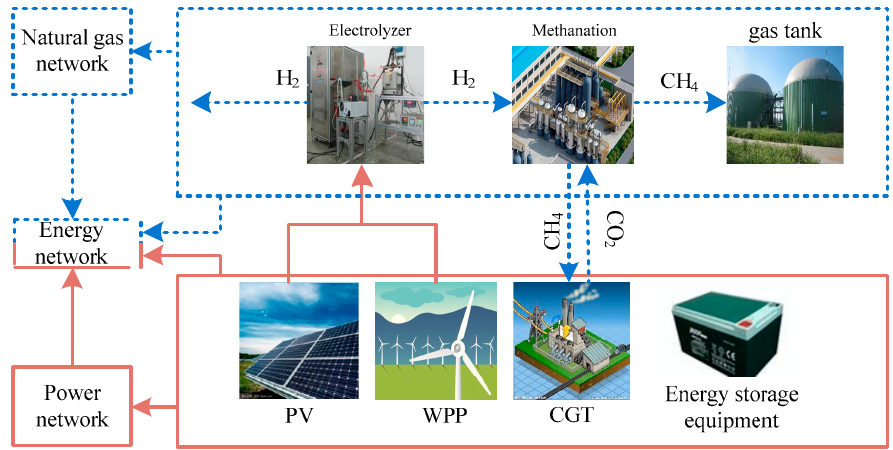
Figure 1. The structure of the integrated energy system with power-to-gas (P2G).